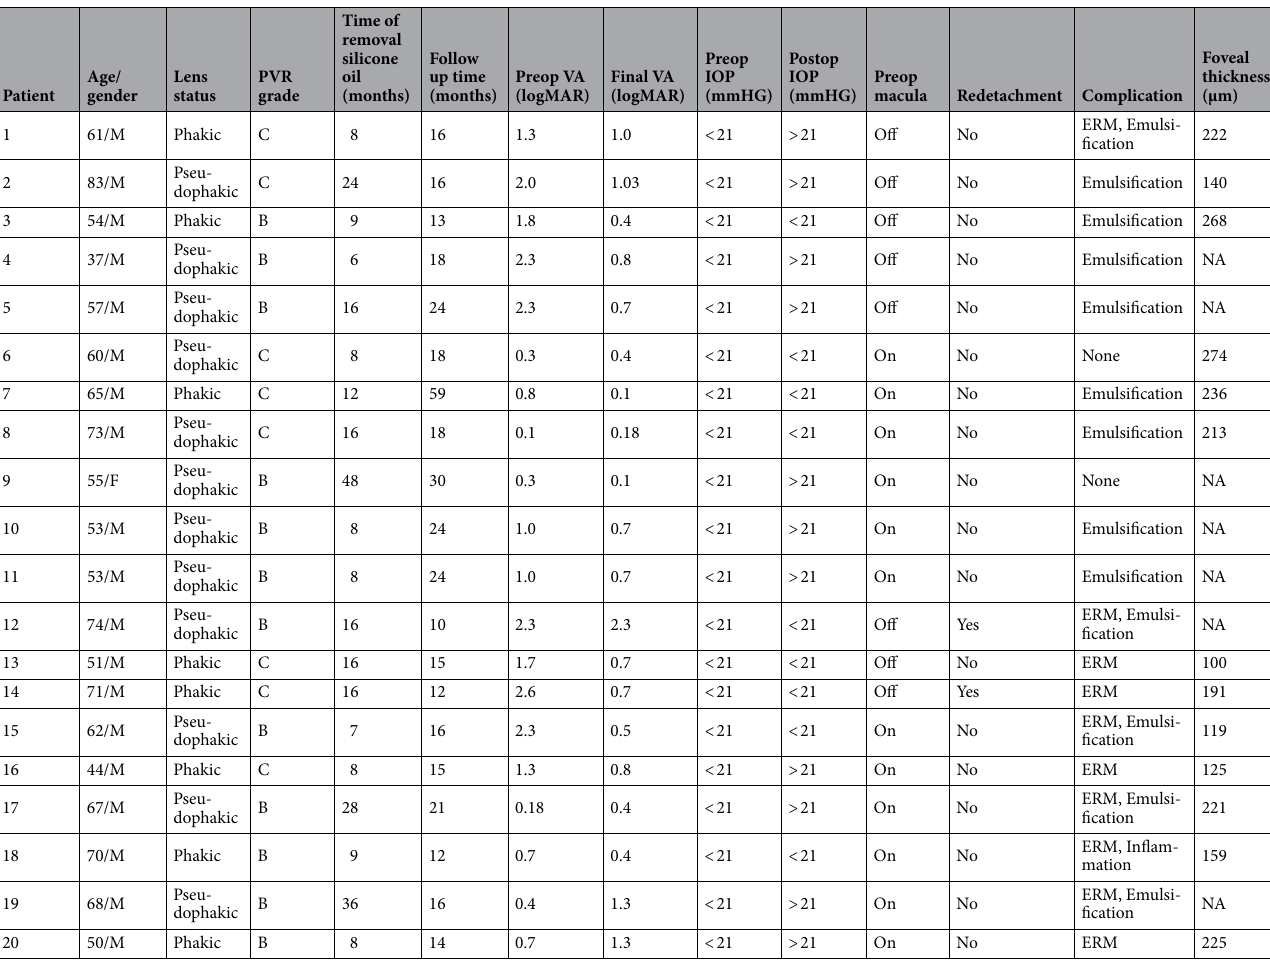
Table 2. Clinical characteristics of the patients. PVR: Proliferative vitreoretinopathy, ERM: epiretinal